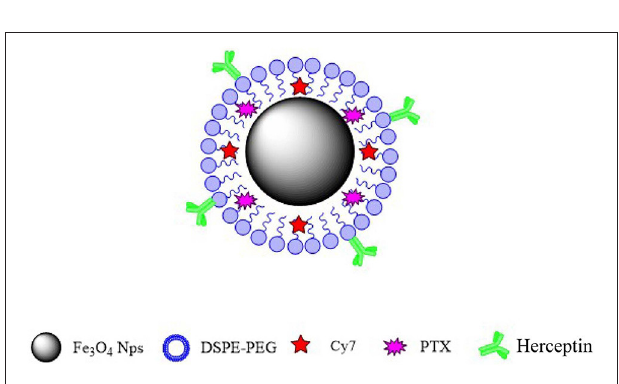
FIGURE 6 | Schematic representation of PTX-Herceptin-MNPs-Fe 3 O 4